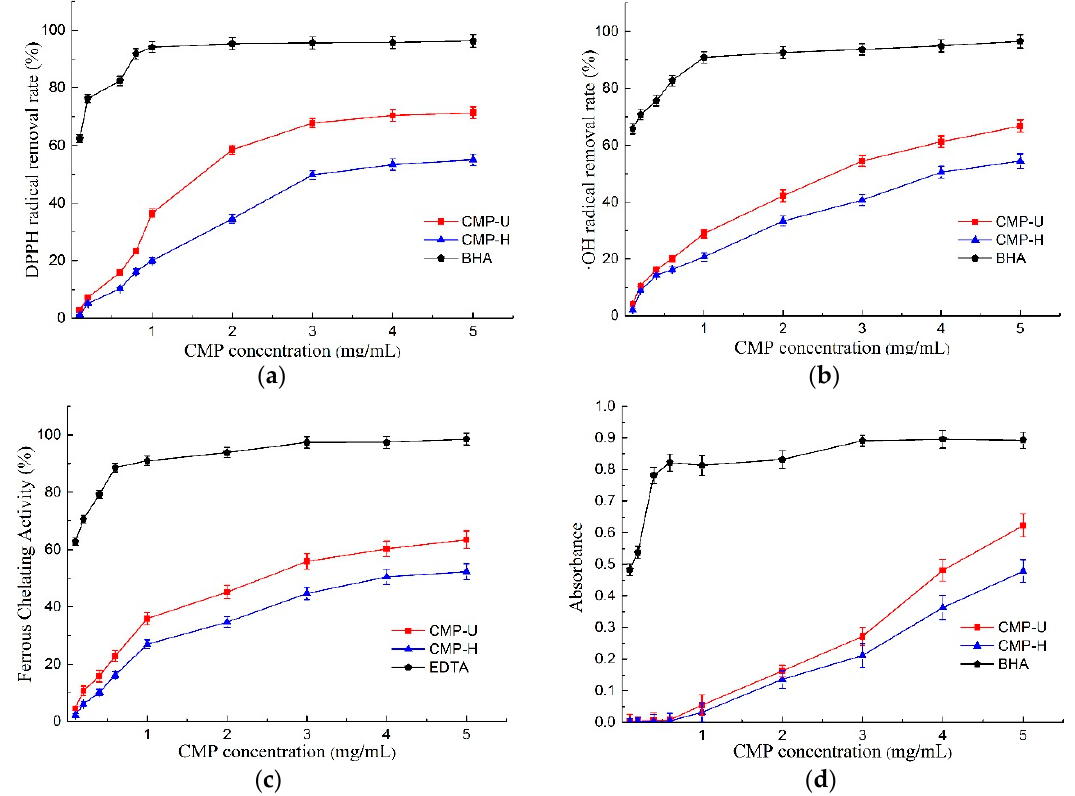
Figure 6. Antioxidant activities of CMP-H and CMP-U. ( a ) DPPH free radical scavenging activity; ( b ) hydroxyl radical scavenging activity; ( c ) ferrous chelating activity, and ( d ) total reducing power. CMP-H: C. morifolium polysaccharides obtained by hot reflux extraction; CMP-U: C. morifolium polysaccharides obtained by ultrasonic assisted extraction.